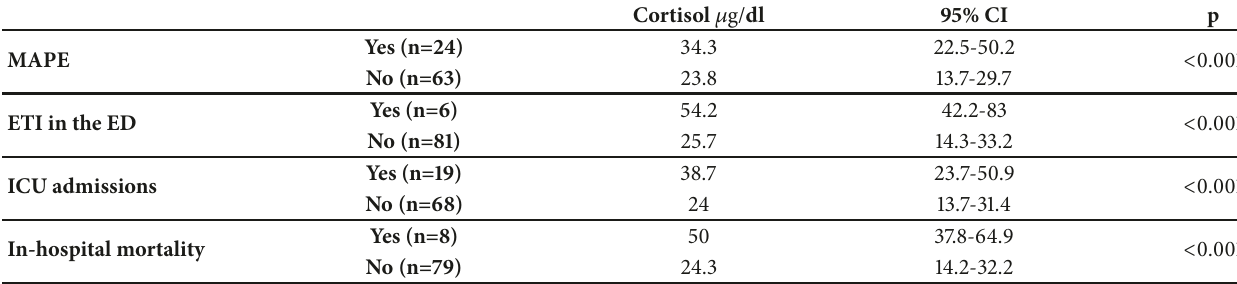
Table 2: Relationship between cortisol levels and MAPE.